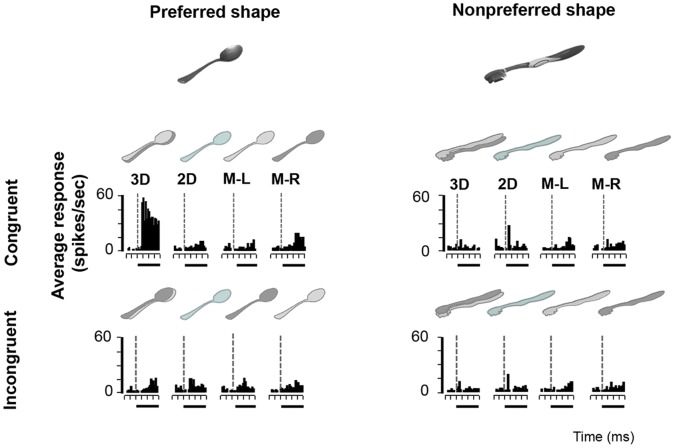
Disparity-selective example neuron.Peristimulus-time histogram (PSTH) of a neuron responding more strongly to the image of a spoon in congruent stereo mode (left top row) compared to the no-stereo mode (left second column) and incongruent stereo mode (left bottom row). No responses were measured in the monocular conditions (left columns 2–4), nor to the image of a toothbrush (right).